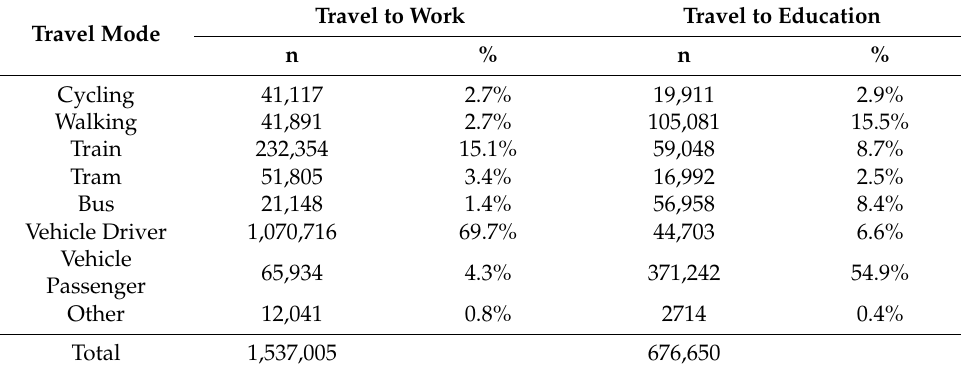
Table 1. Travel to work and education trips by mode (weekday).